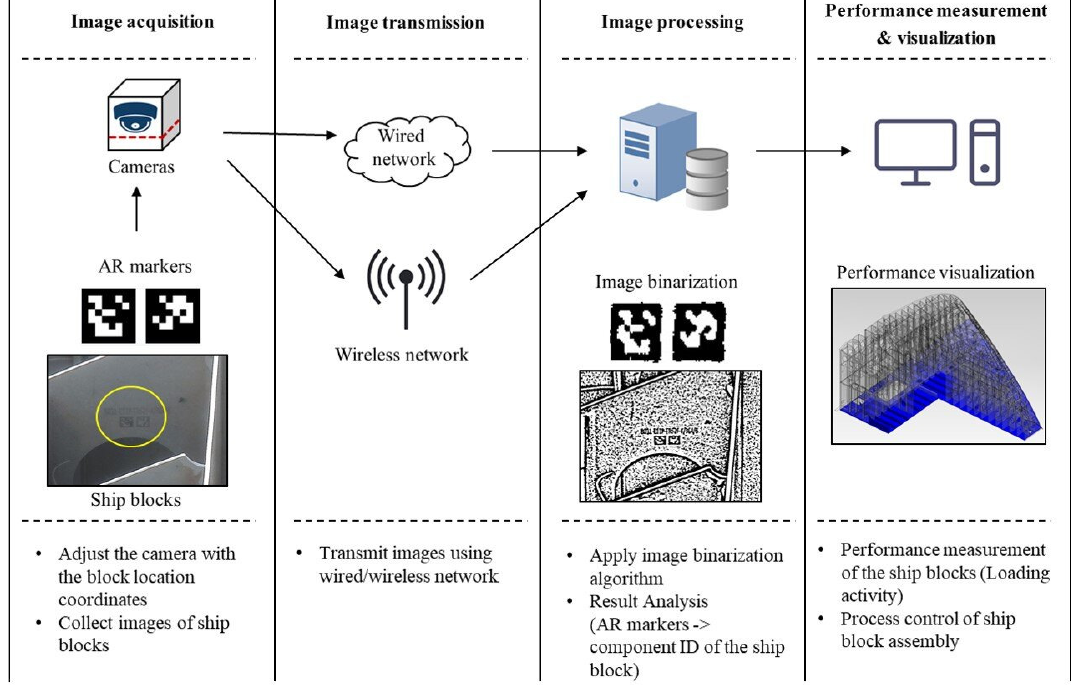
Figure 4. Procedure of the performance measurement of mounting